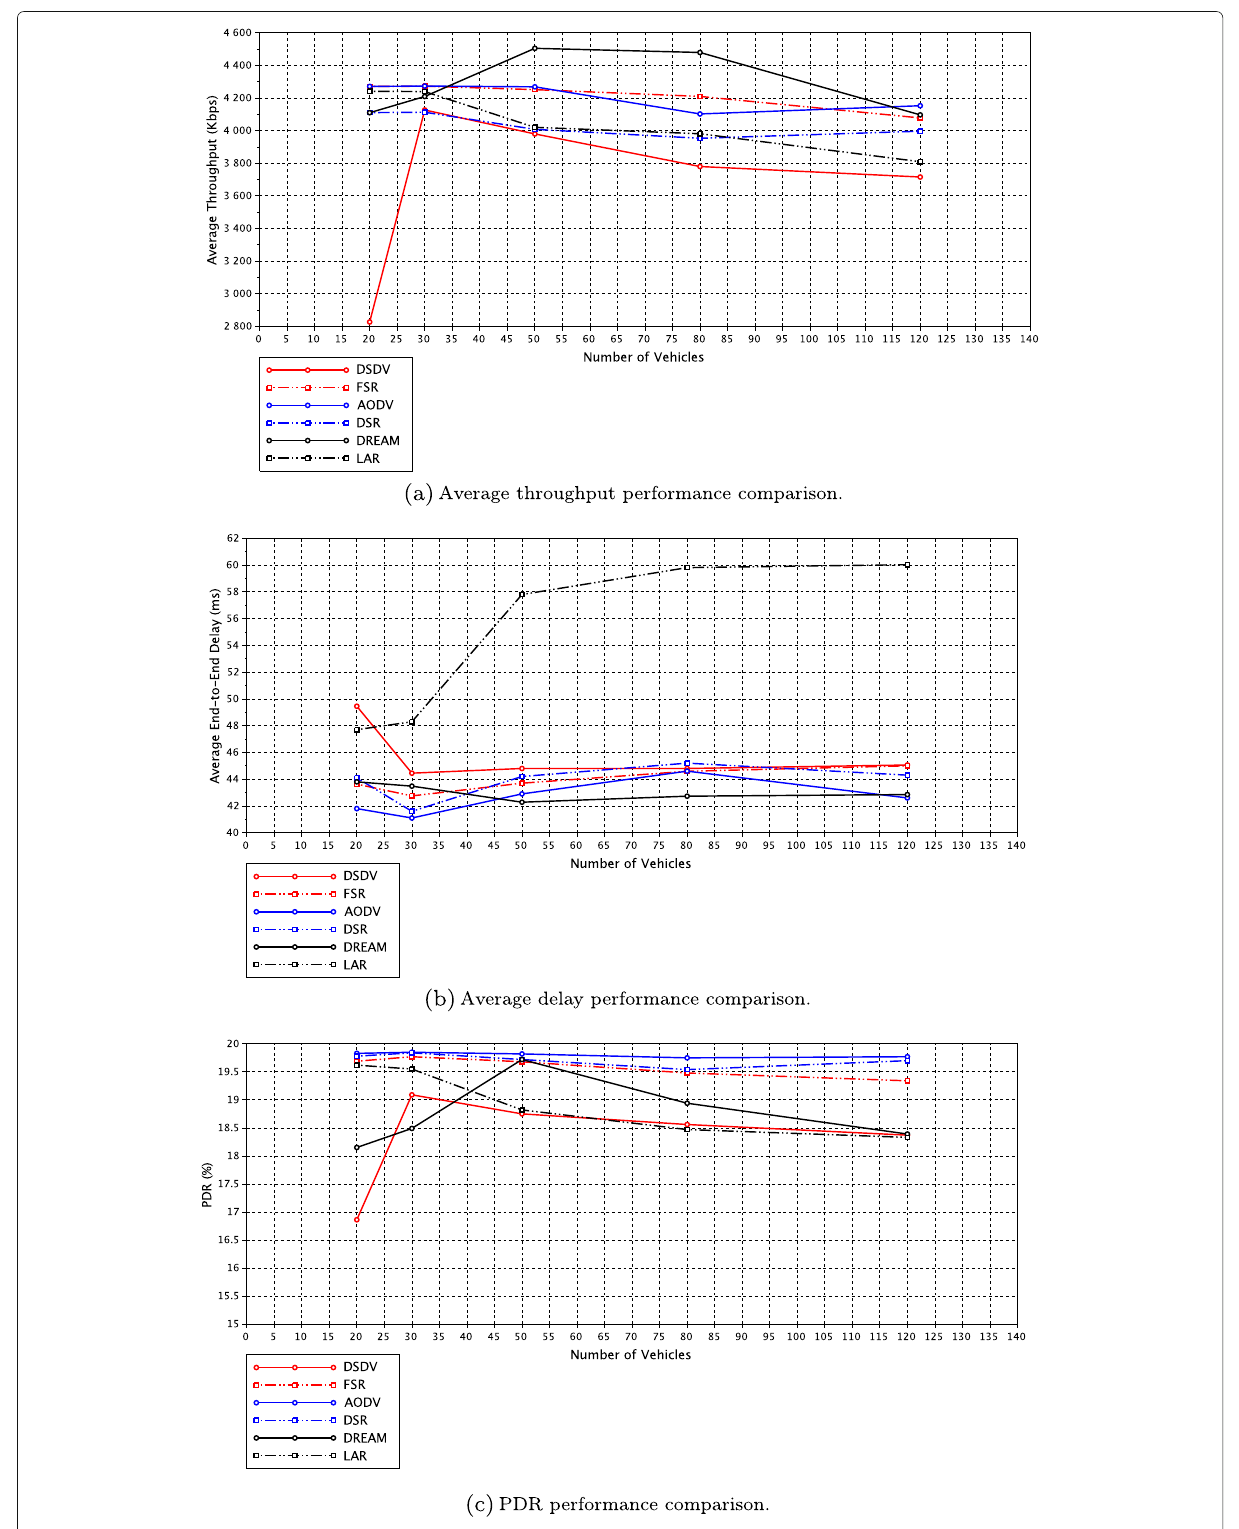
Fig. 5 Average throughput, end-to-end delay and PDR performance under increasing vehicle density. a Average throughput performance comparison. b Average delay performance comparison. c PDR performance